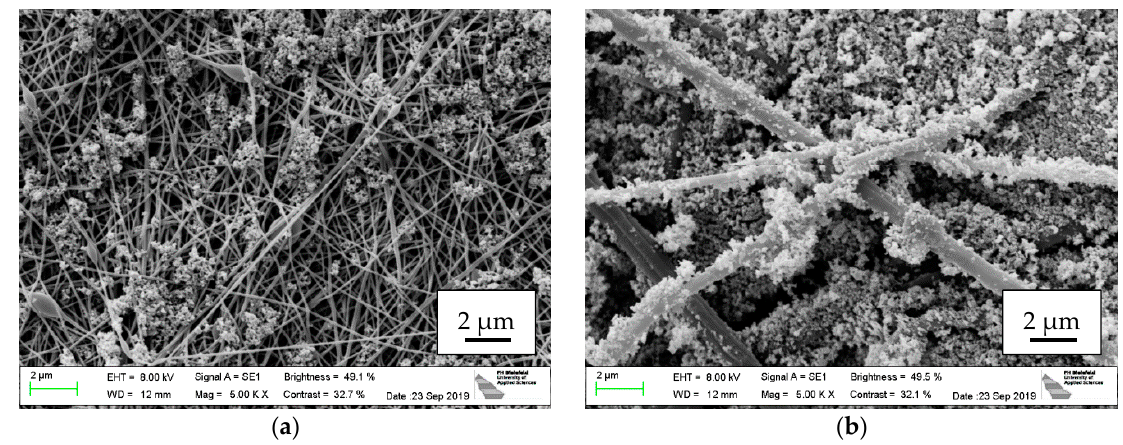
Figure 3. SEM images of ZnO nanoparticles, applied by dip-coating on ( a ) a PAN nanofiber mat; ( b ) a PAN/ZnO nanofiber mat, after rinsing the substrates with water.